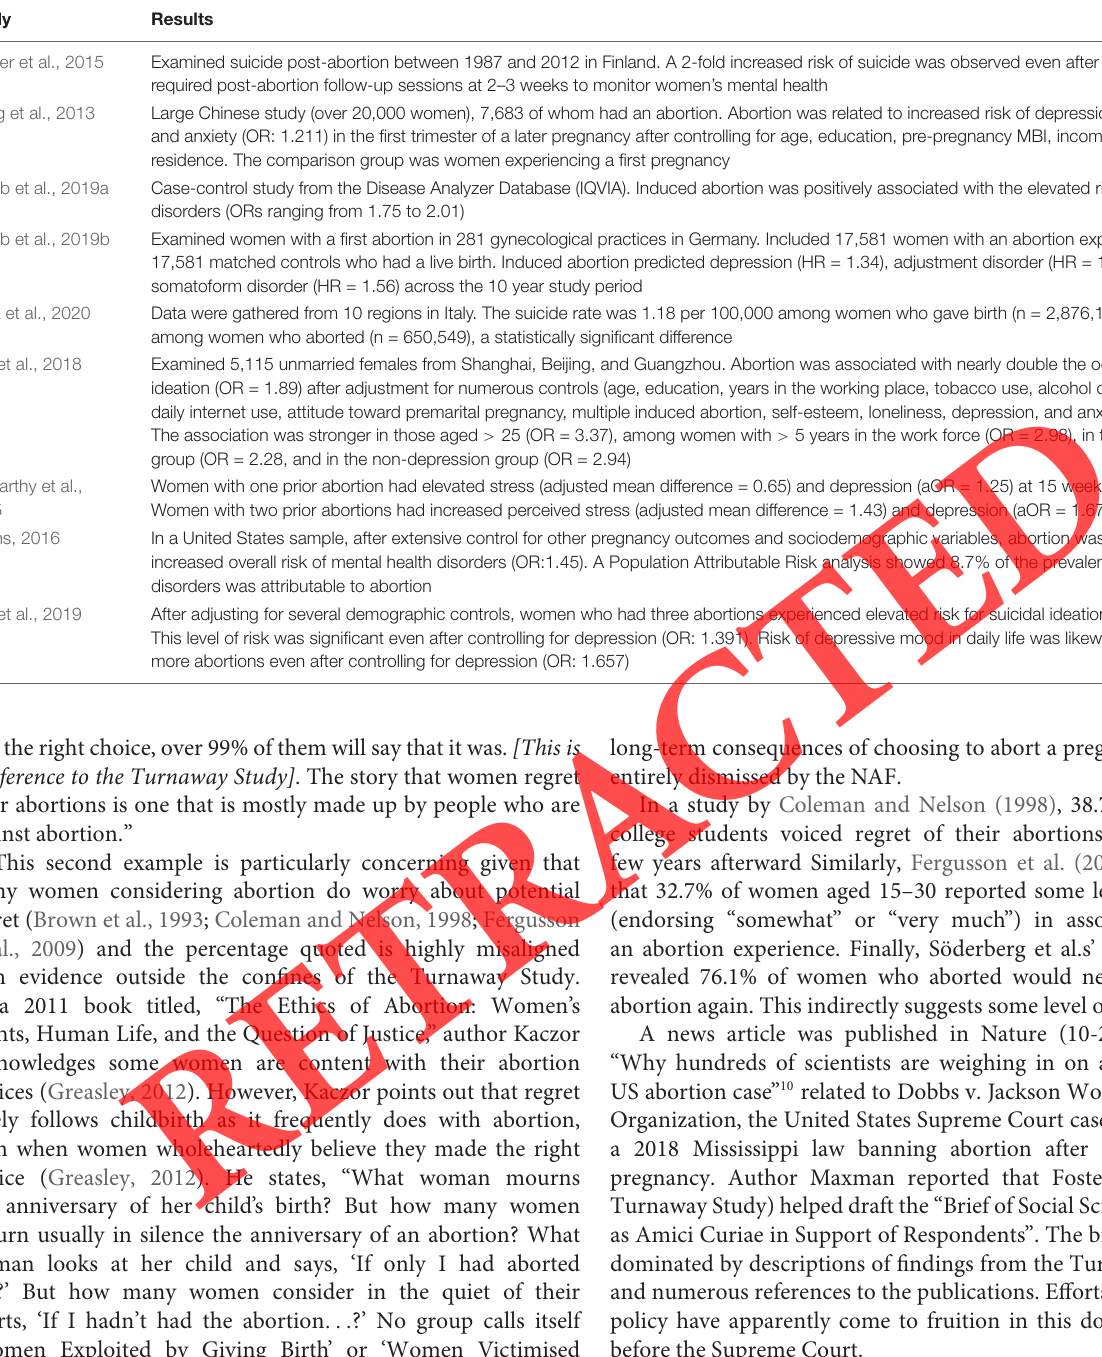
Jacob et al., 2019a